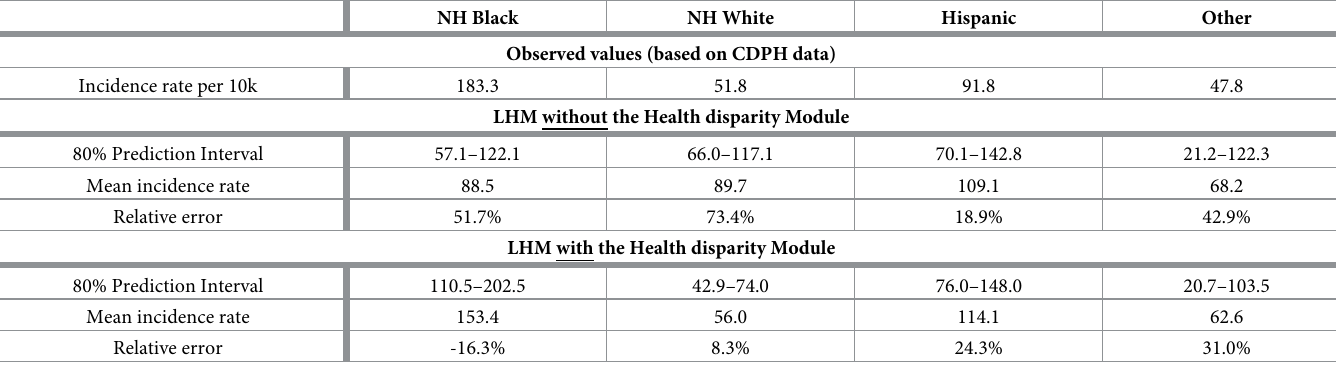
Table 4. Observed and predicted rates of HIV incidence for MSM by Race/Ethnicity. NH Black NH